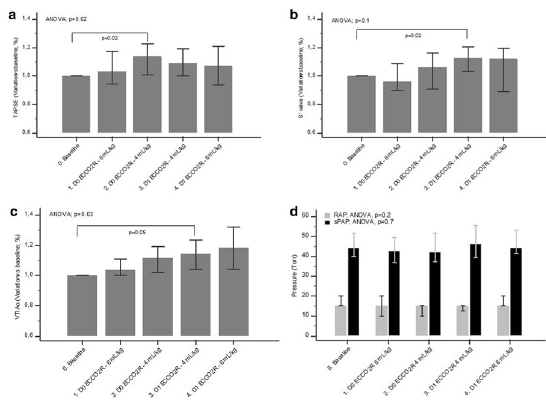
Fig. 1 Time course of echocardiography variables during the study